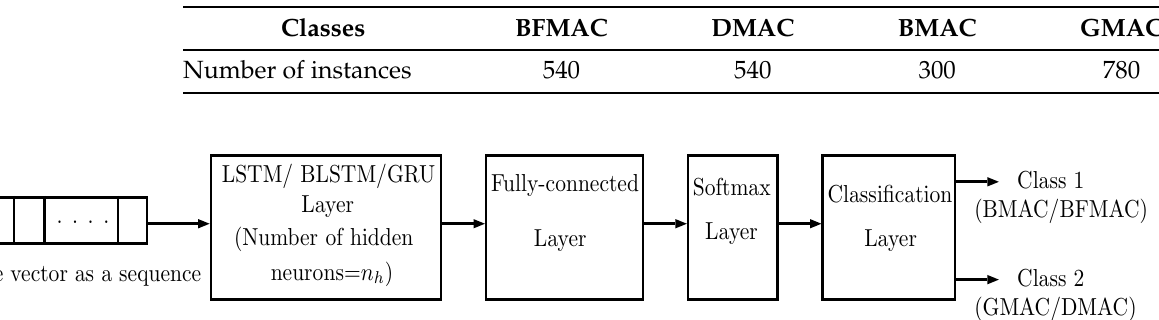
Figure 5. Classification of mental arithmetic task using EEG feature vector sequence with different RNN